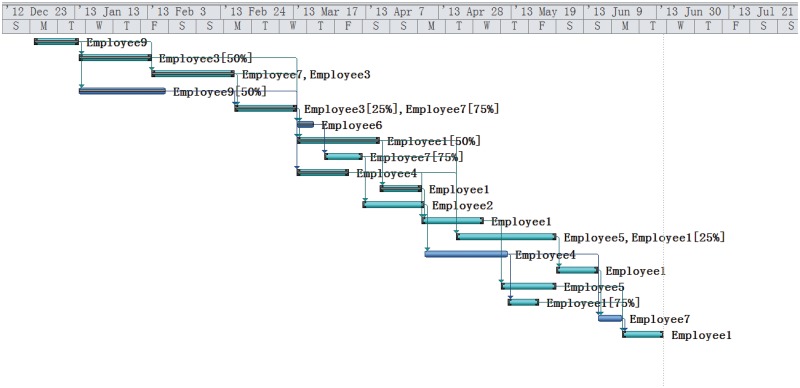
Initial Schedule and Project Execution.